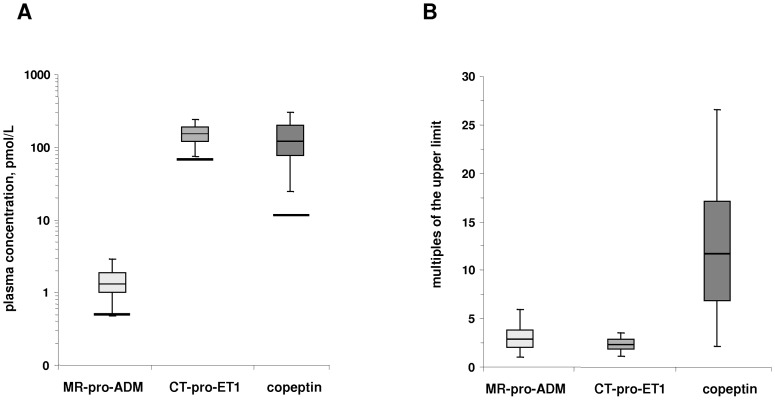
Box-and-Whisker-Plot of the plasma vasoactive peptide concentration indicating median, IQR and the range between the 2.5th and 97.5th percentile (Panel A).Solid lines represent the upper reference limit. Panel B: Box-and-Whisker-Plot of the plasma vasoactive peptide concentration expressed as multiples of the upper reference limit.